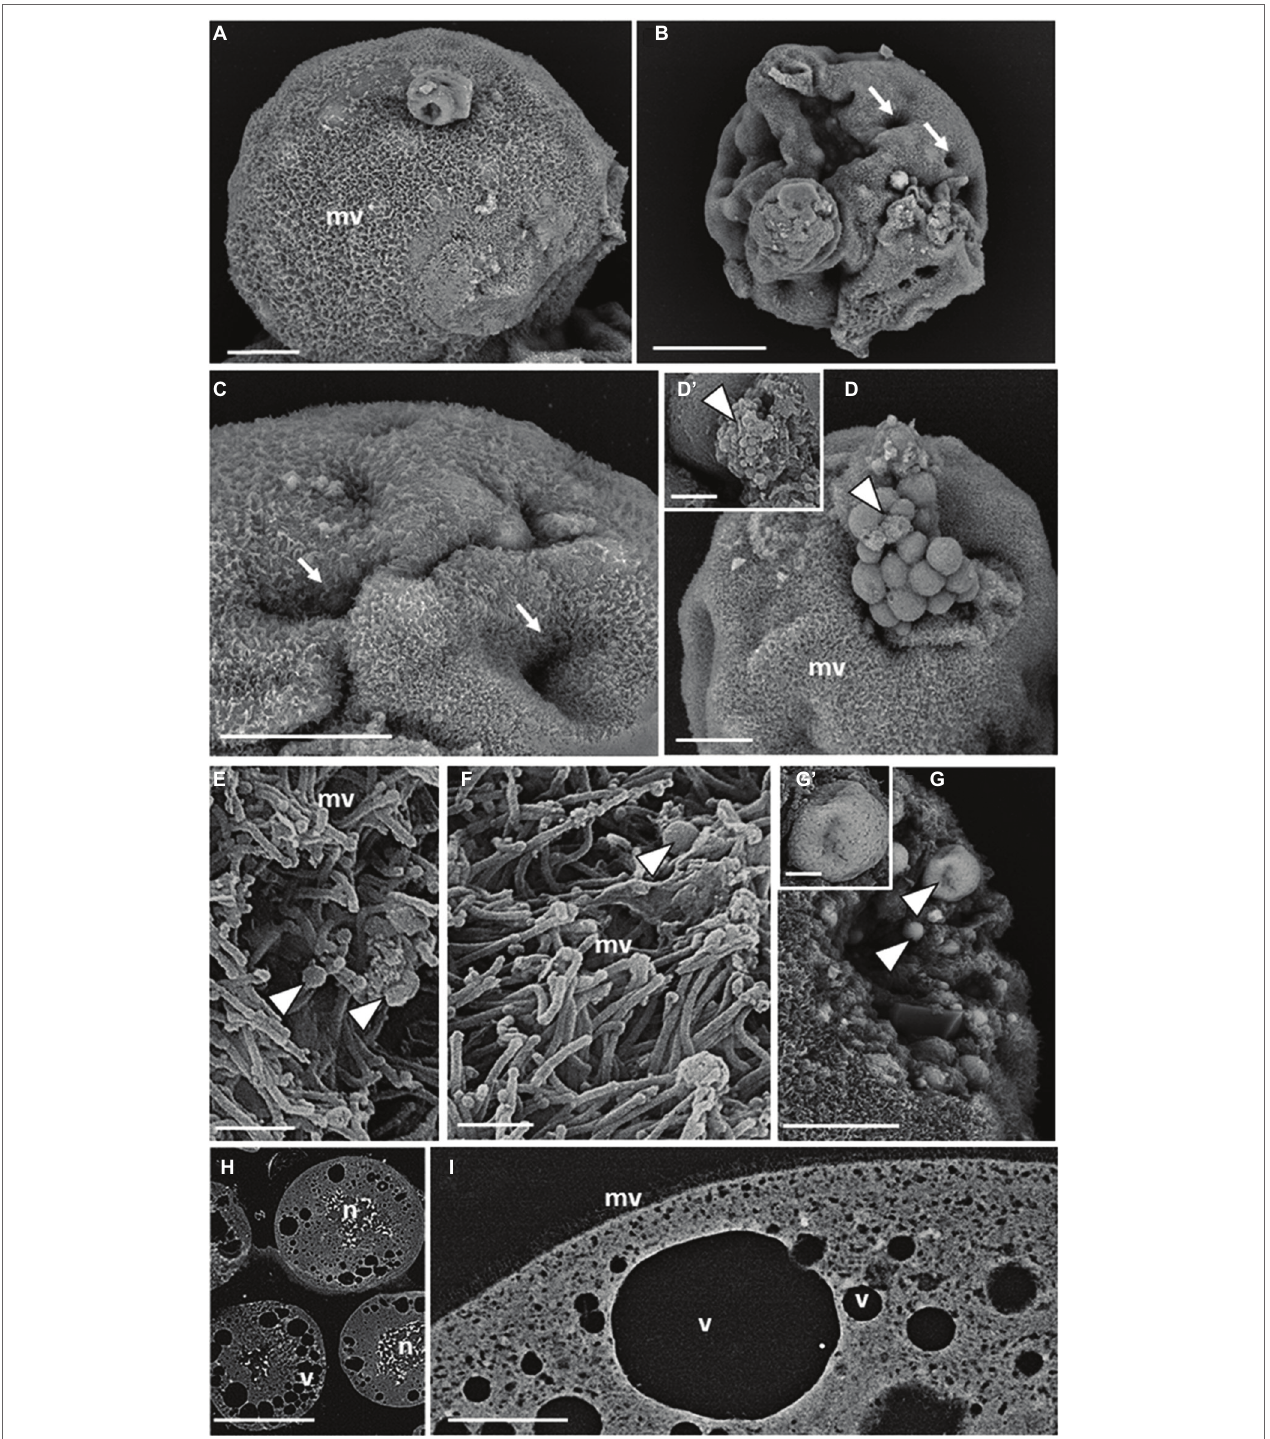
FIGURE 2 | SEM micrographs of teratocytes. Teratocytes isolated from pea aphids 5 days after parasitization by A. ervi have a surface covered with numerous microvilli (A) and are characterized by the presence of indentations or dimple-like structures (B,C) . Spherical vesicles and structures similar to exosomes protrude from the plasma membrane [arrowheads in (D,D ′ ) ]. Numerous exosome-like structures [arrowheads in (E,F) ] are interspersed among the microvilli. Spherical vesicles filled with smaller vesicles with circular profiles are visible in the cytoplasm [arrowheads in (G,G ′ ) ]. Large stellate nuclei (H) and vacuoles (H,I) are visible in the sectioned teratocytes. (mv) microvilli, (n) nucleus, (v) vacuoles. Bars in (A,C,D,G) : 20 μm; bar in (B) : 50 μm; bars in (D ′ ,G ′ ) : 2.5 μm; bars in (E,F) : 1 μm; bar in (H) : 100 μm; bar in (I) : 10